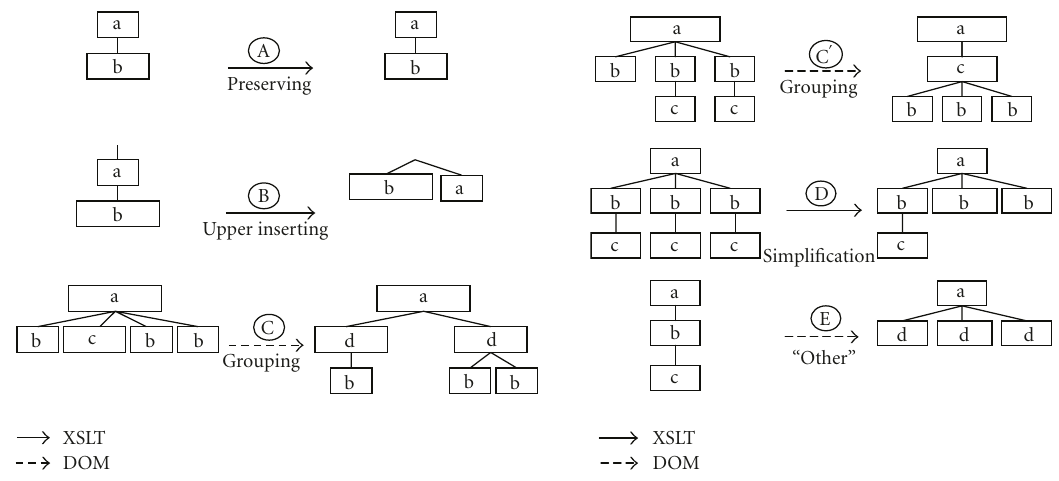
Figure 7: Categories of structure transformation from MusicXML trees to Braille music trees. The left side indicated by an arrow is a part of MusicXML trees and the right side a part of Braille music trees. Preserving is used for cases such as the lower-level element of note element, upper inserting for cases such as octave, accidental, and dot element, grouping for cases such as backup and chord element, simplification for cases such as time modification and note element. “Other” category contains all other possible transformations based on individual elements such as key and direction elements. Here a transformation for the key element is shown as a simple example.